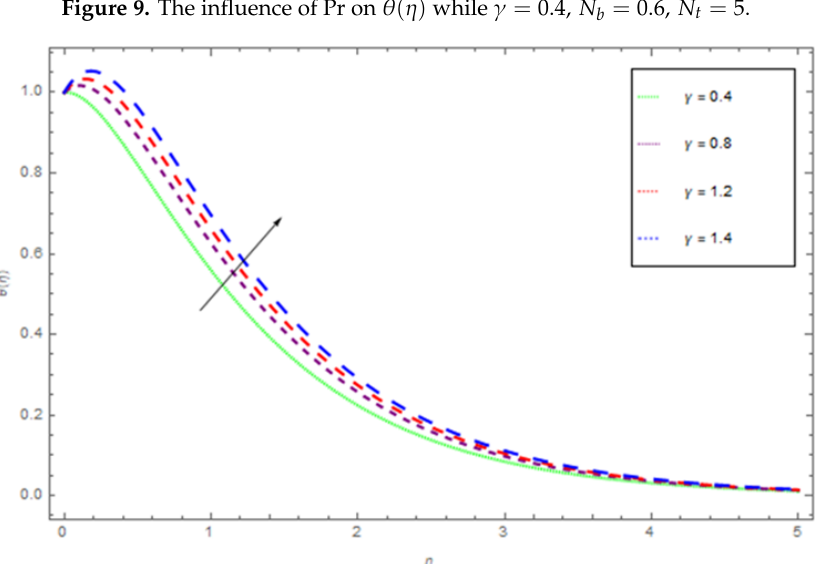
Figure 9. The influence of Pr on θ ( η ) while γ = 0.4, N b = 0.6, N t = 5.